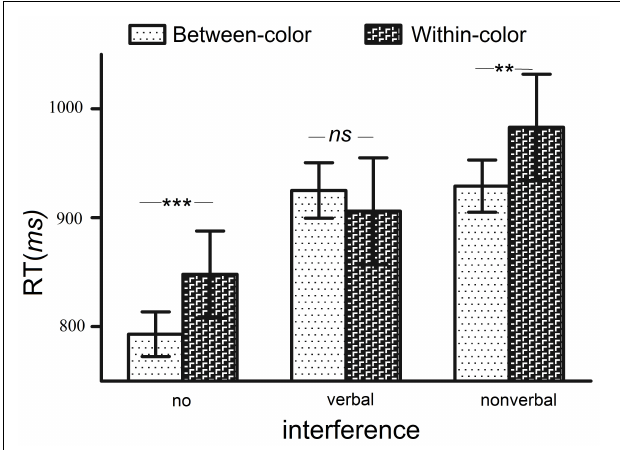
FIGURE 5 | Mongolian speakers’ reaction times under the no-interference, verbal-interference, and nonverbal-interference conditions. The no-interference results replicated those obtained in experiment 2. Under the nonverbal-interference condition, the performance followed a pattern similar to that observed in the no-interference condition. ∗∗ P < 0.01, ∗∗∗ p < 0.001, ANOVA, df = 35; ns , nonsignificant. Error bars represent a 95% CI.